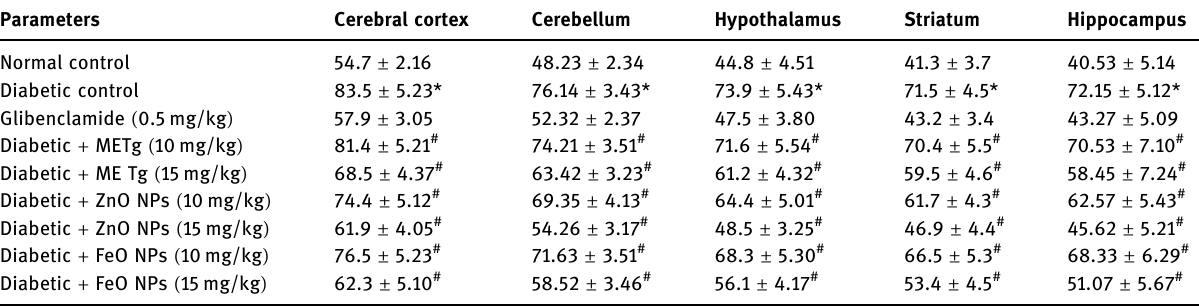
Table 4: E ff ect of T. glabra methanolic extract and their mediated ZnO NPs and Fe 2 O 3 NPs on AChE potential in di ff erent brain portions of diabetic rats Parameters